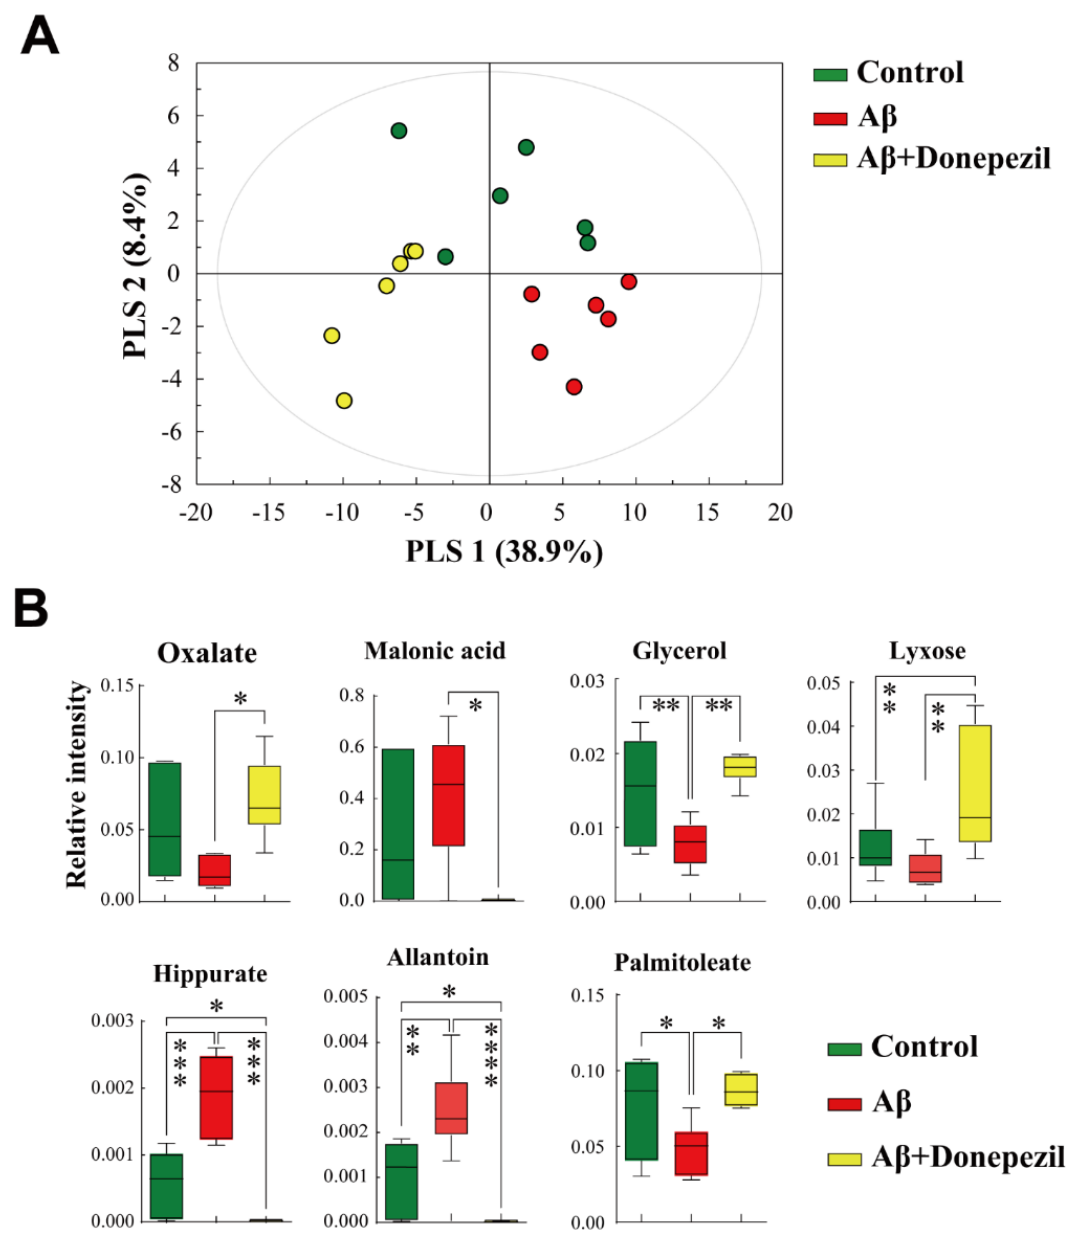
Figure 4. ( A ) Supervised partial least squares discriminant analysis (PLS-DA) score plot derived from gas chromatography-mass spectrometry (GC-MS) data of feces. ( B ) Box plots of significantly different metabolites in feces. *, p < 0.05; **, p < 0.01; ***, p < 0.001; ****, p < 0.0001. A false discovery rate (FDR) of 5% was applied to all tests to correct for multiple testing.